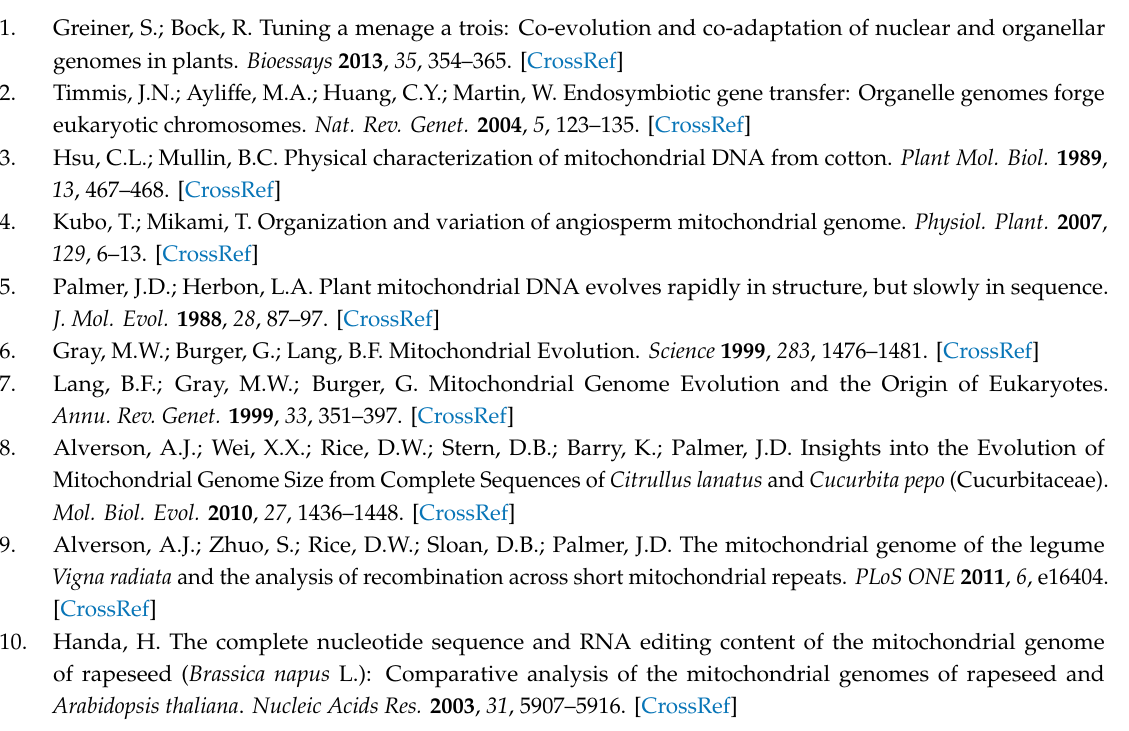
Figure S1: The flowchart of P. vulgaris mitogenome assembly and annotation, Table S1: PacBio reads of spanning repetitive contigs, Table S2: The abbreviations and genome sizes of studied mitogenomes, Table S3: The relative synonymous codon usage (RSCU) of mitogenome genome across seven higher plants, Table S4: Comparison of dispersed repeats within six mitogenomes of Papilionaceae